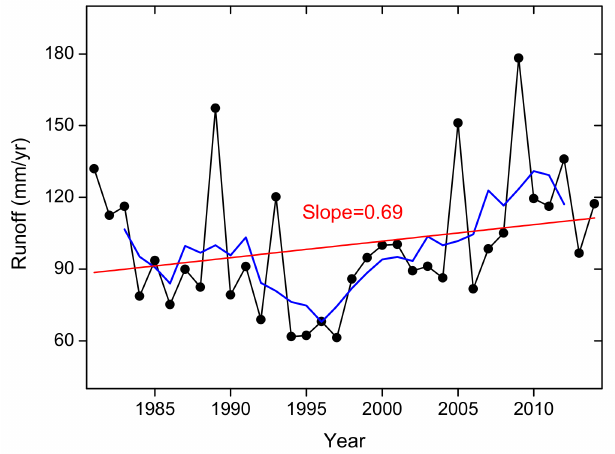
Figure 2. Interannual variation of observed runo ff across the study basin. The red line indicates the fitted linear trend in the annual runo ff time series, and the blue line shows the five-year moving average of the annual runo ff time